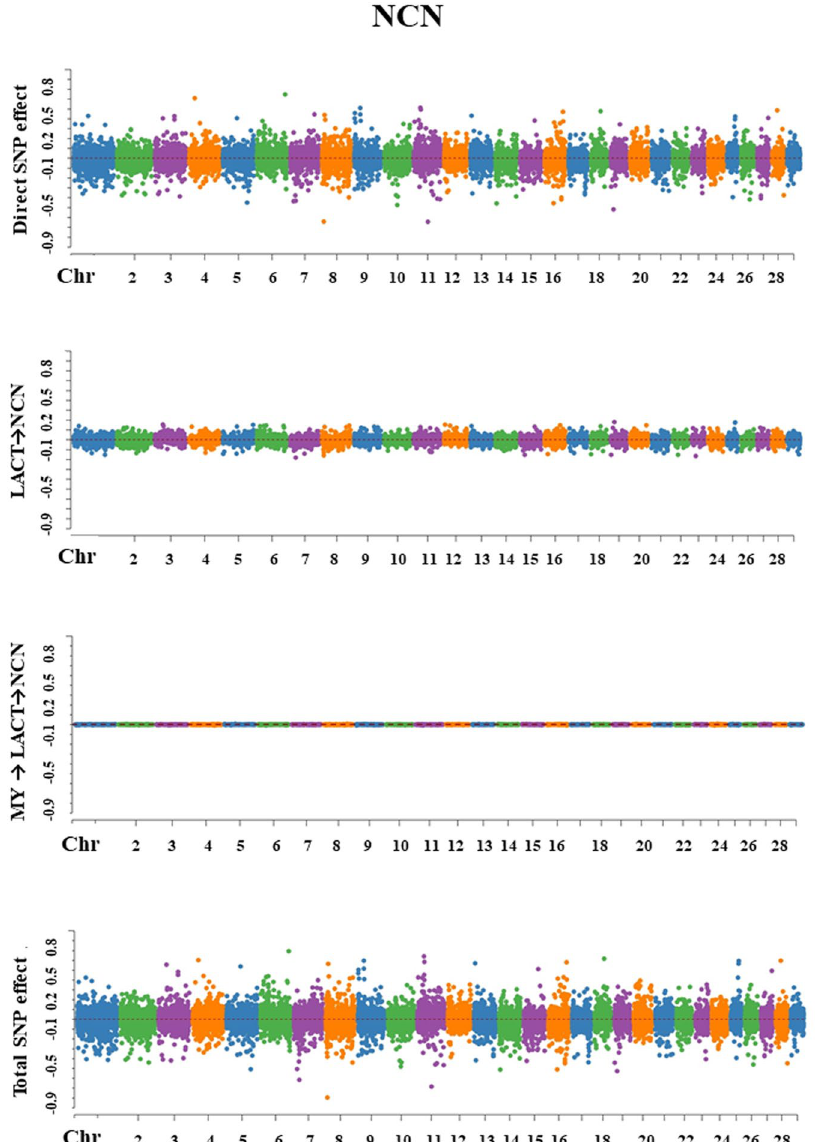
Figure 7. Manhattan plots for SNP effects on non-casein N obtained using SEM-GWAS based on the network structure learned by Hill-Climbing algorithm. MY: milk yield; LACT: lactose; NCN: non- casein N (expressed as % of total milk